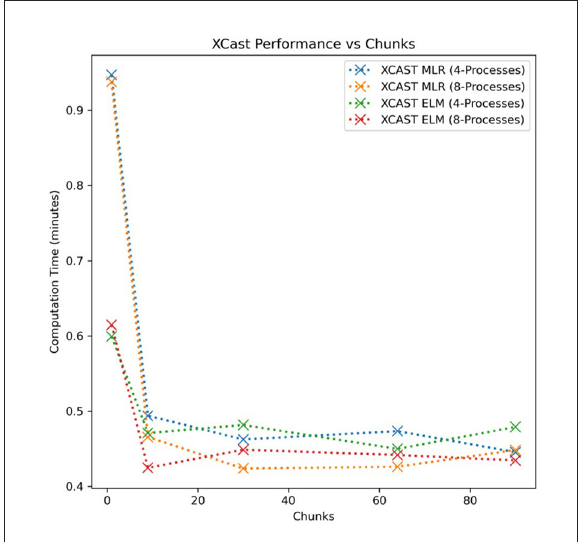
FIGURE5 XCast training time plotted against the number of chunks in the training data. Two Dask clusters configurations with different numbers of parallel processes are compared.